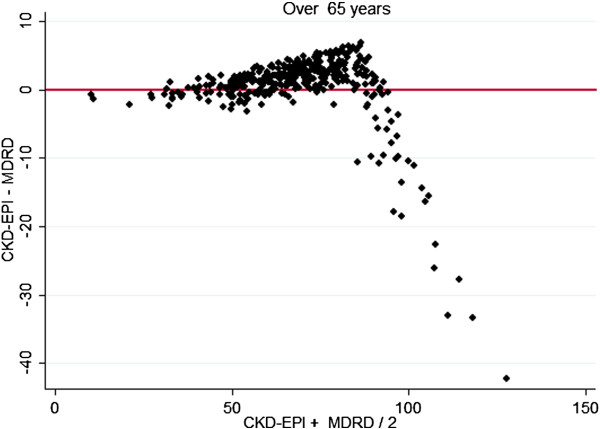
Bland Altman Plots (X axis mean CKD-EPI, MDRD, Y axis CKD-EPI − MDRD) in subjects over 65 years.